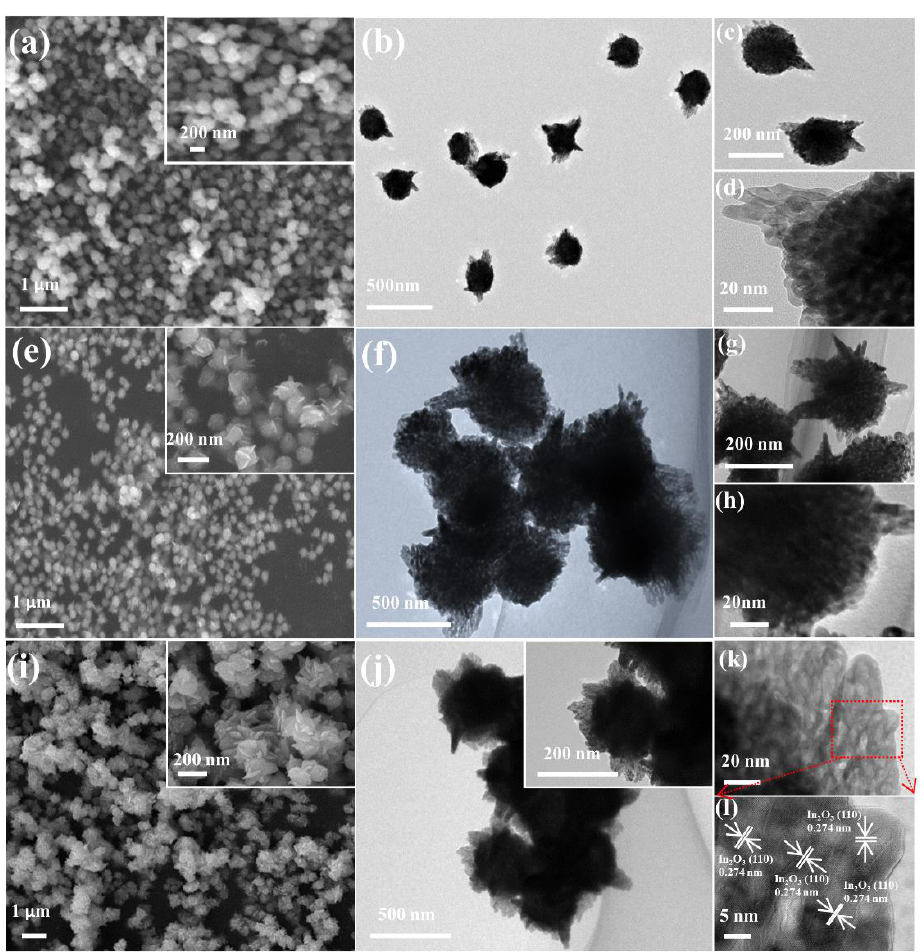
Figure 2. ( a ) FESEM image and ( b – d ) TEM image of the 18-In 2 O 3 ; ( e ) FESEM image and ( f – h ) TEM image of the 24-In 2 O 3 ; ( i ) FESEM image, ( j , k ) TEM image and ( l ) HRTEM image of the 48-In 2 O 3 .